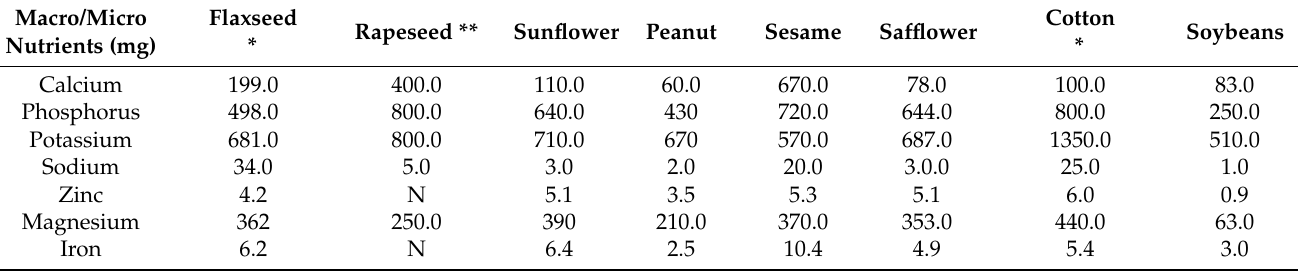
Table 3. Mineral content of oilseeds (100 g) (adapted from Food Standards Agency